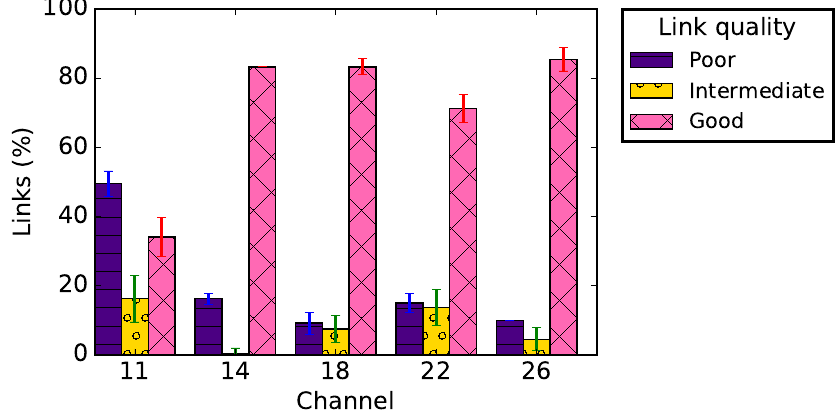
Figure 11. Link quality classification for different communication